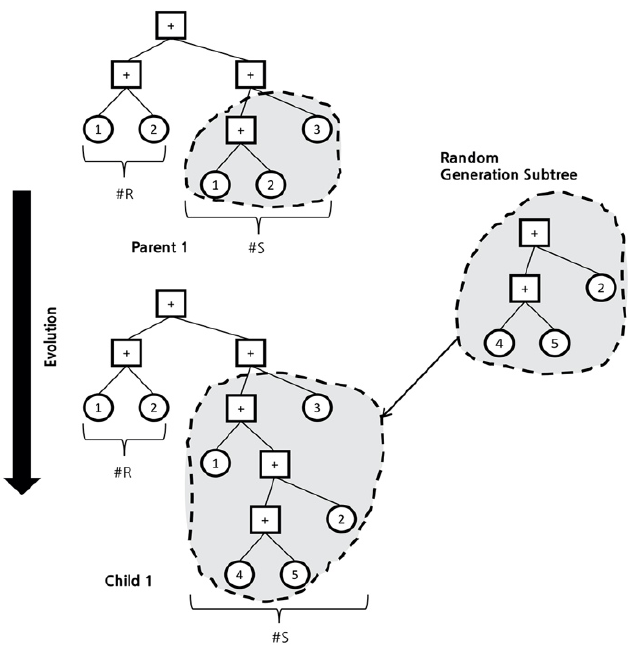
Figure 8. Concept of the mutation method in GP.